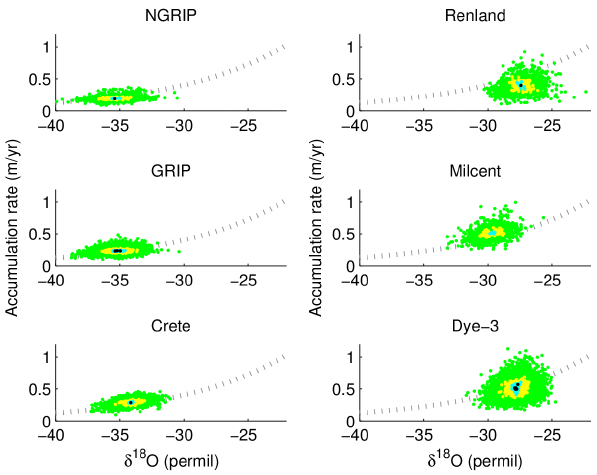
Fig. 2. Mean values of accumulation rate and δ 18 O for the six longest records in our data set. The averaging periods are 1yr (green), 10yr (yellow), 100yr (cyan), and 1000yr (black). The dot- ted grey line shows the relation from Dahl-Jensen et al. (1993) (Eq. 1). See Table 1 for the time periods covered by each data series.